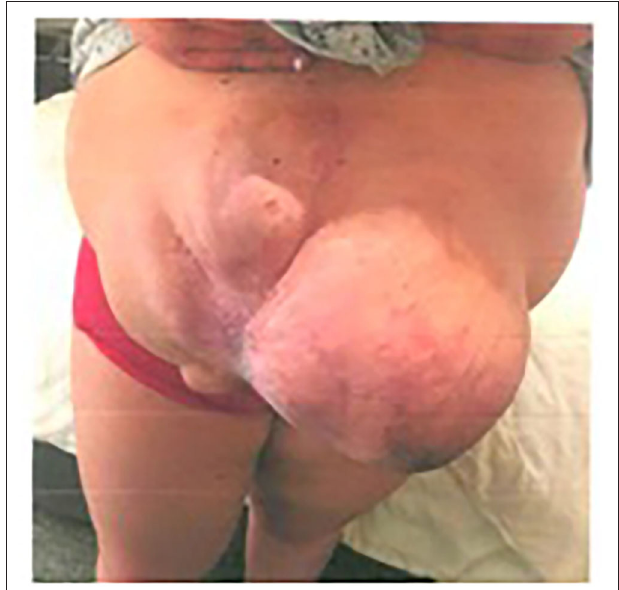
FIGURE 1 | Schematic diagram of Fasciotens® by courtesy of Fasciotens GmbH